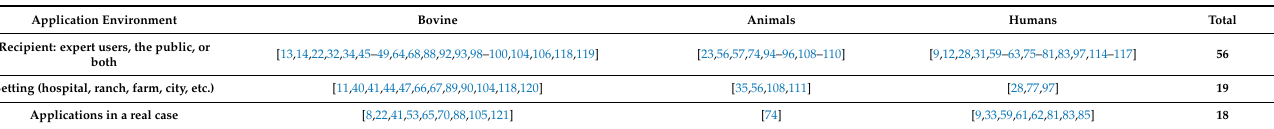
Table 2. Result of comparing related job–application environment group.